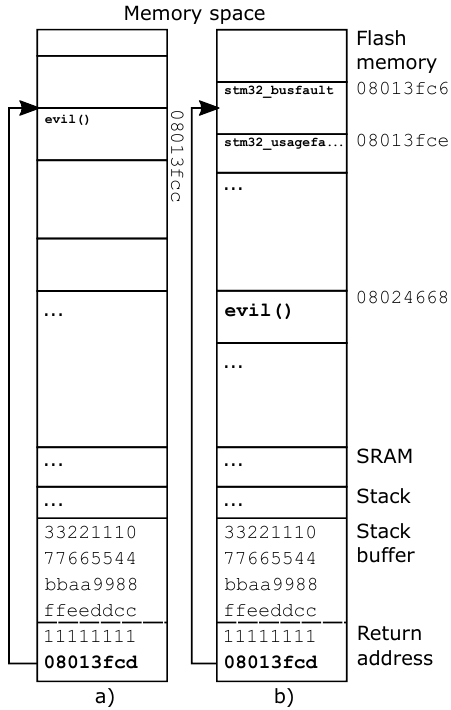
Figure 1. An example of a possible execution of the exploit in a normal and diversified operating system. ( a ) normal OS: execution jumps to the beginning of the function evil; ( b ) OS layout diversification: in this particular case, the execution jumps to the middle of an instruction.